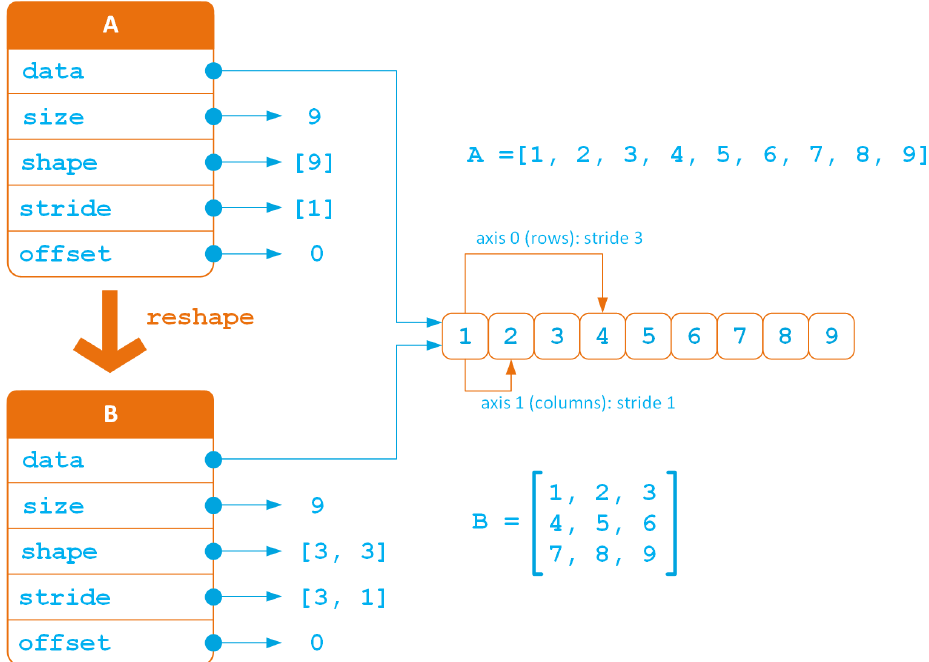
Figure 6. Memory organisation after array